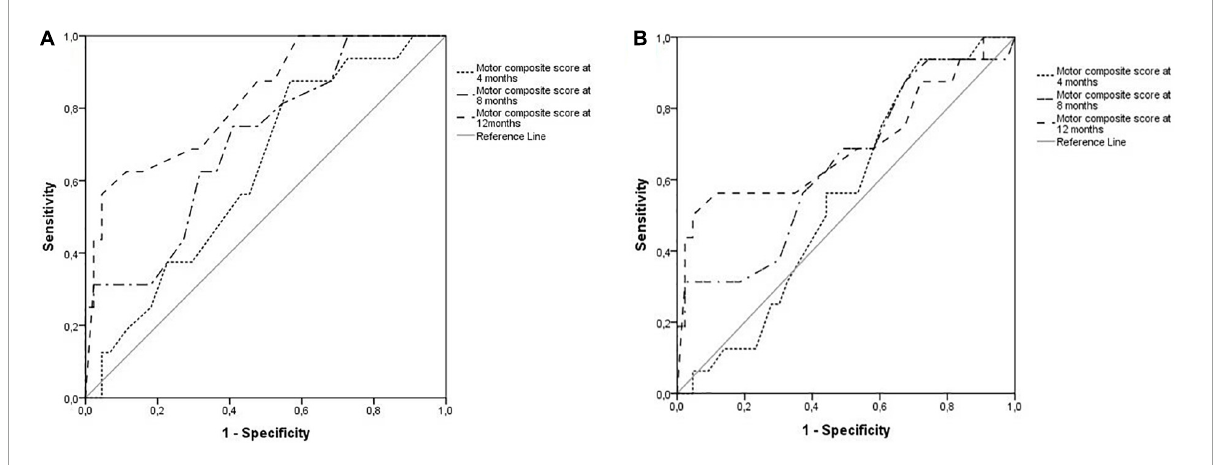
FIGURE2 ROC curves for cognition (A) and language (B)